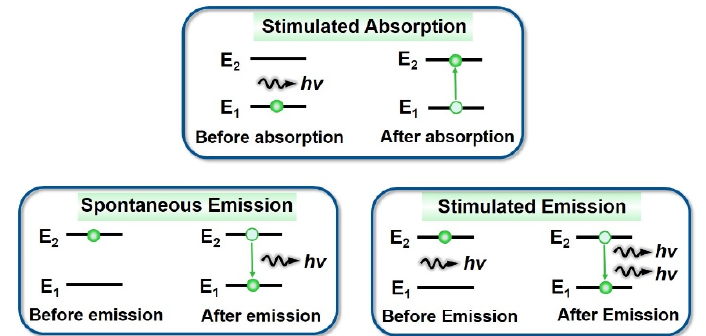
Figure 4. Processes of stimulated absorption, spontaneous emission, and stimulated emission.